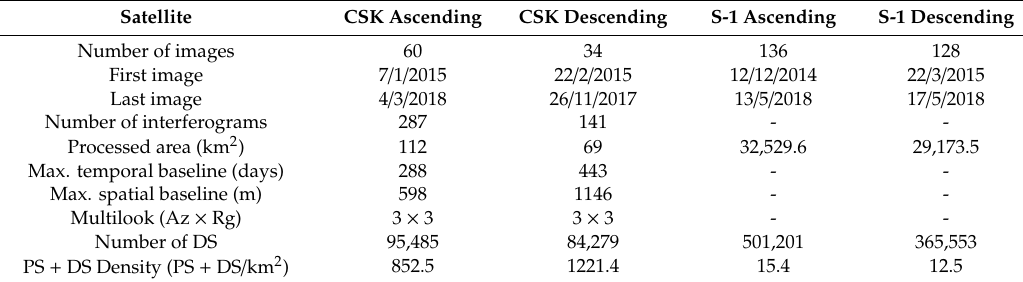
Table 1. COSMO-SkyMed (CSK) and Sentinel-1 (S-1) processing parameters. Satellite CSK Ascending CSK Descending S-1 Ascending S-1 Descending